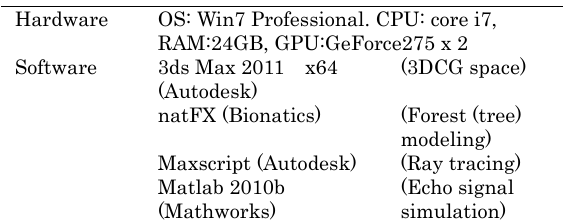
Table 1. The development